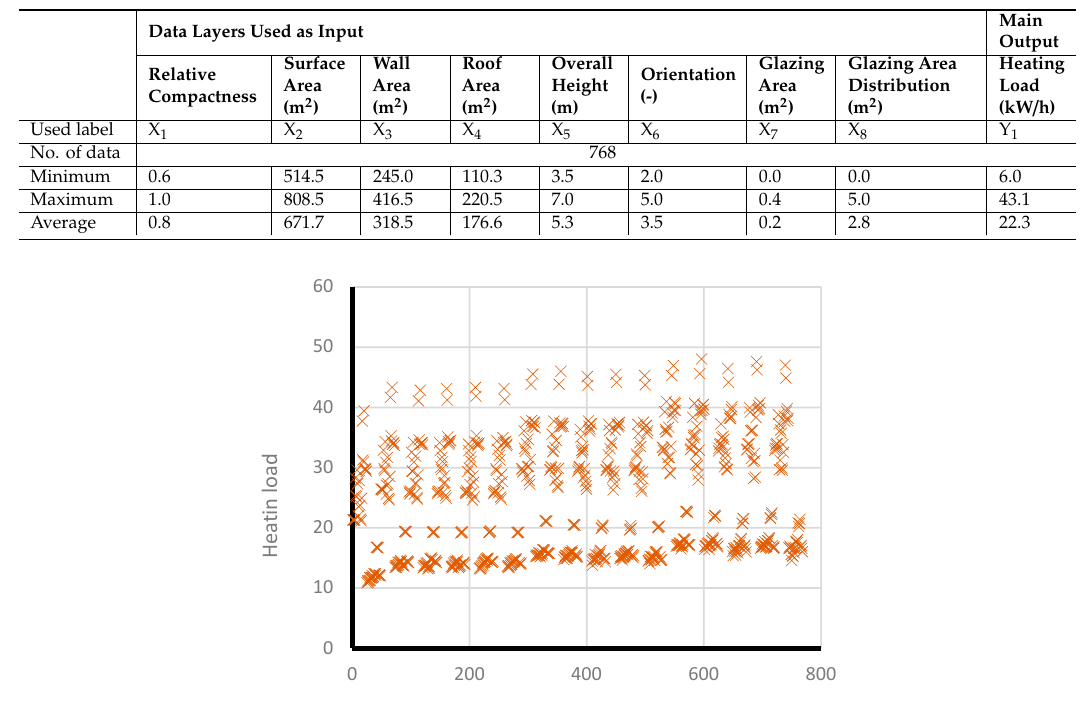
Table 1. The statistical description details in term of energy-e ffi cient design.